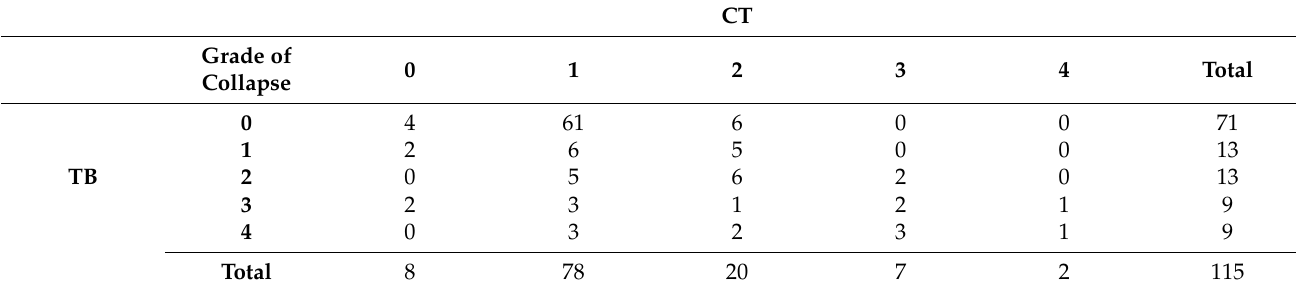
Table 5. Comparisons of scores for airway caliber narrowing using inspiratory/expiratory breath- hold CT and tracheobronchoscopy (tracheobronchoscopy) for the trachea and mainstem bronchi (right and left principal bronchi). The CT-determined percentage of dynamic airway wall narrowing based on dorsoventral diameter and subjective tracheobronchoscopic narrowing were each used to assess a score (in bold) from 0–4 as shown in Table 1. Numbers which are not in bold reflect the number of airways evaluated for each grade of collapse for each imaging